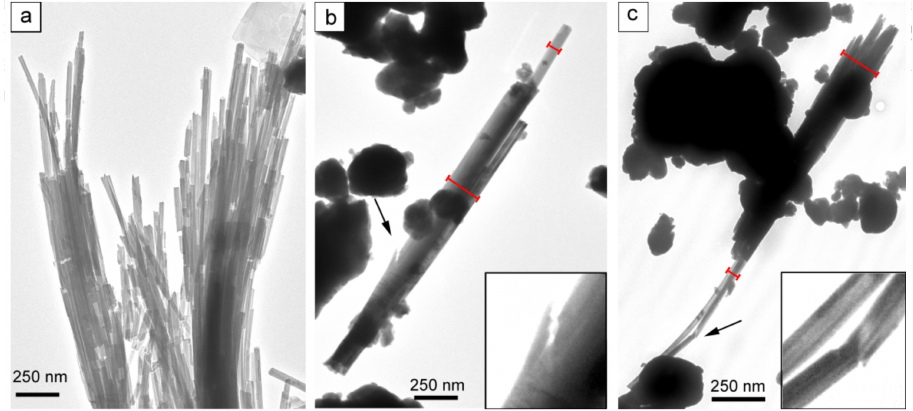
Figure 9. TEM images of: chrysotile ( a ); amosite ( b ); crocidolite ( c ) after 5 min of grinding. Arrows in ( b , c ) indicate the zoom area. The red lines in b and c indicate the diameter of the fibres.